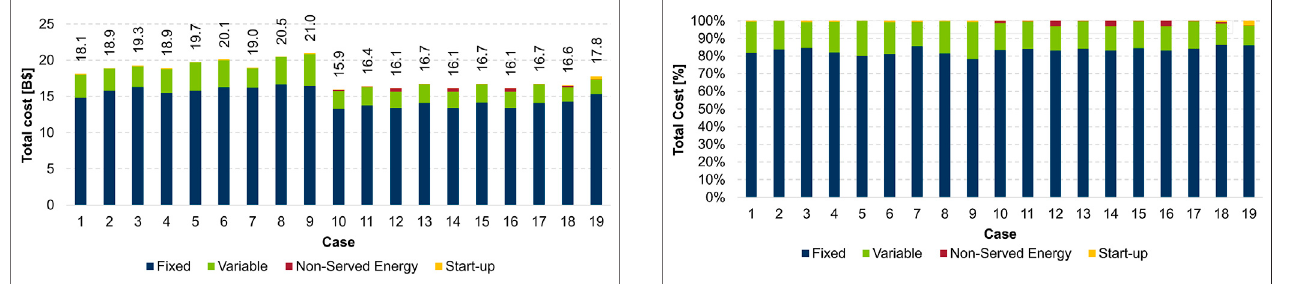
FIGURE 9 | Fixed, variable, nonserved energy, start-up, and total cost for each case in billion